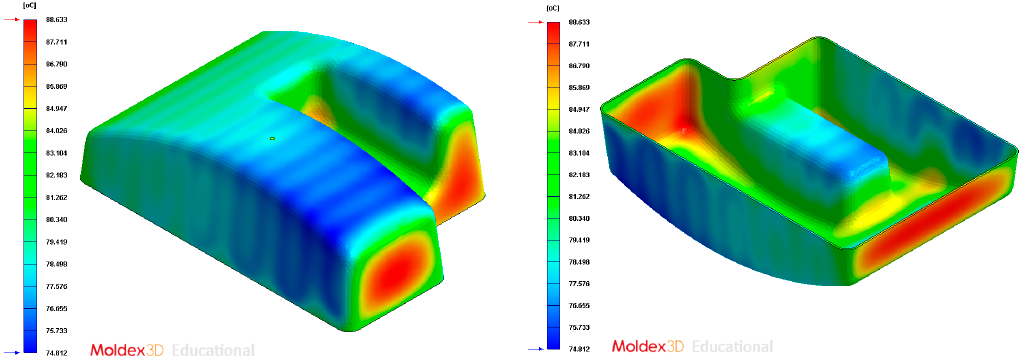
Figure 35. Pressure (MPa) of the coolant along the cooling system, Case D.